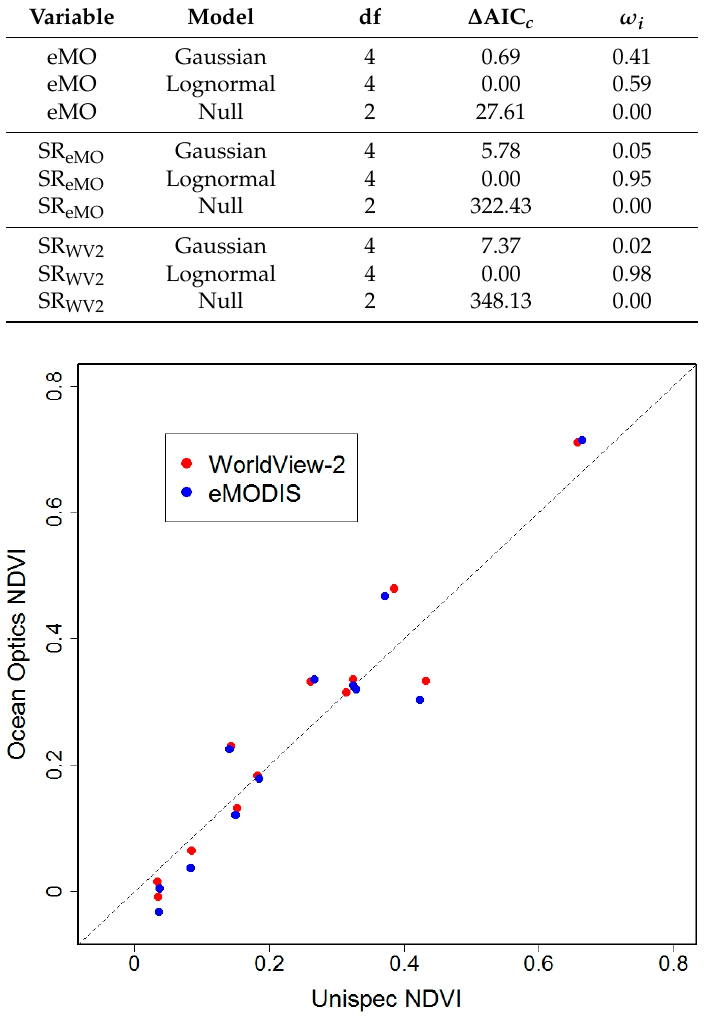
Figure A1. Comparison of NDVI values collected using two different handheld spectrometer units (OceanOptics and Unispec) with WorldView-2 (red) and eMODIS (blue) band definitions. Readings were collected at 12 plots representing a range of biomass values in halophytic graminoids. The dotted line through the origin represents the slope of a 1:1 relationship. Results of paired t -tests indicate that the units did not significantly differ in their readings (WorldView-2 t11 = 0.58, p = 0.57; eMODIS t11 = − 0.05, p = 0.96).